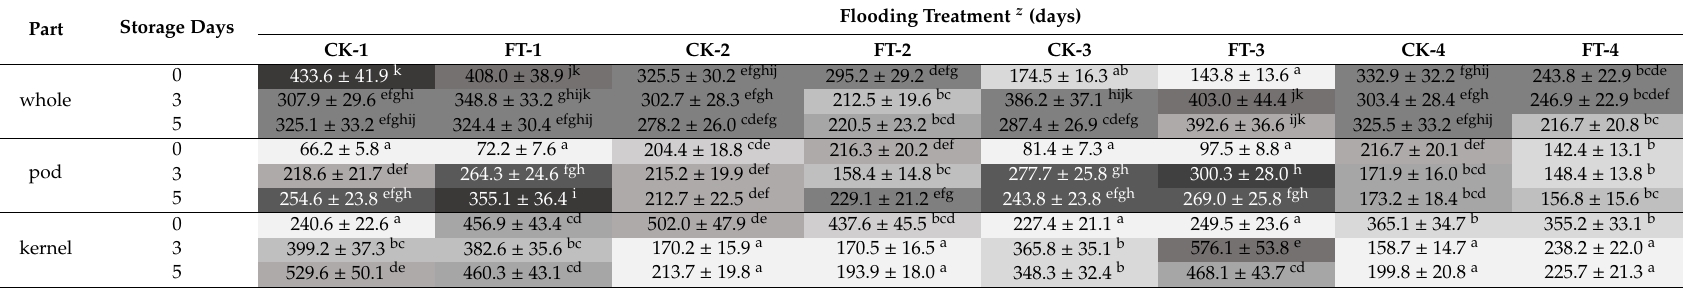
Table 2. Influence of flooding treatment and cold storage on GABA content in di ff erent parts of vegetable soybeans ‘Kaohsiung 9’. Part